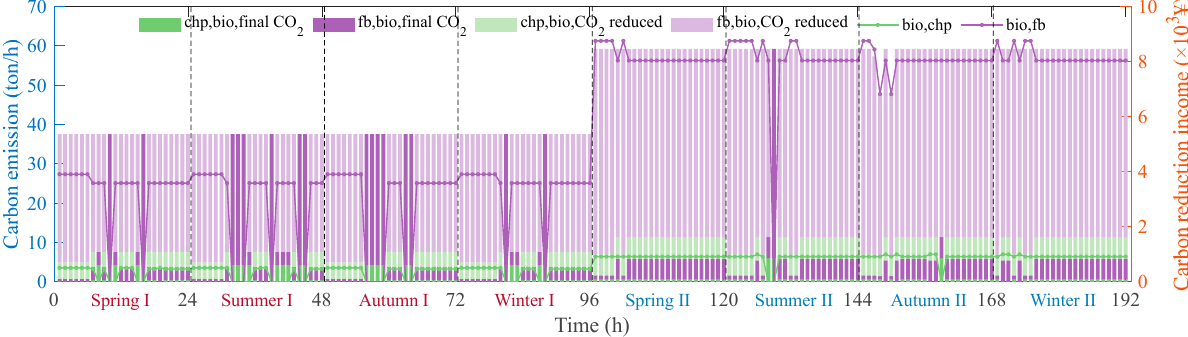
Figure 12. “Negative Carbon Emission” E ff ect of Biomass Fuel Equipment in Two Stages of Case 1.